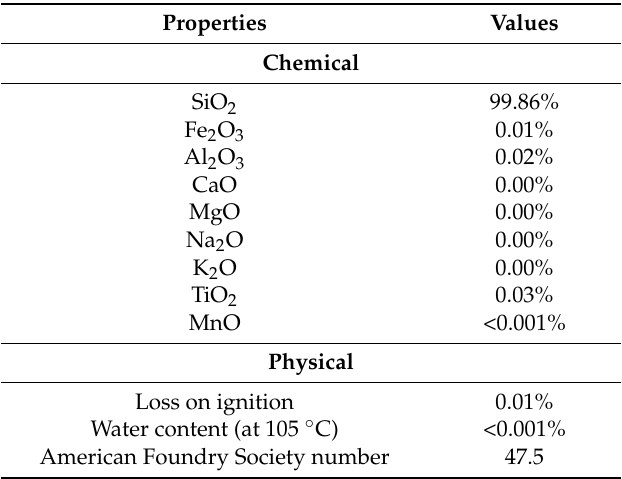
Table 4. Properties of natural fine sand (45/50).